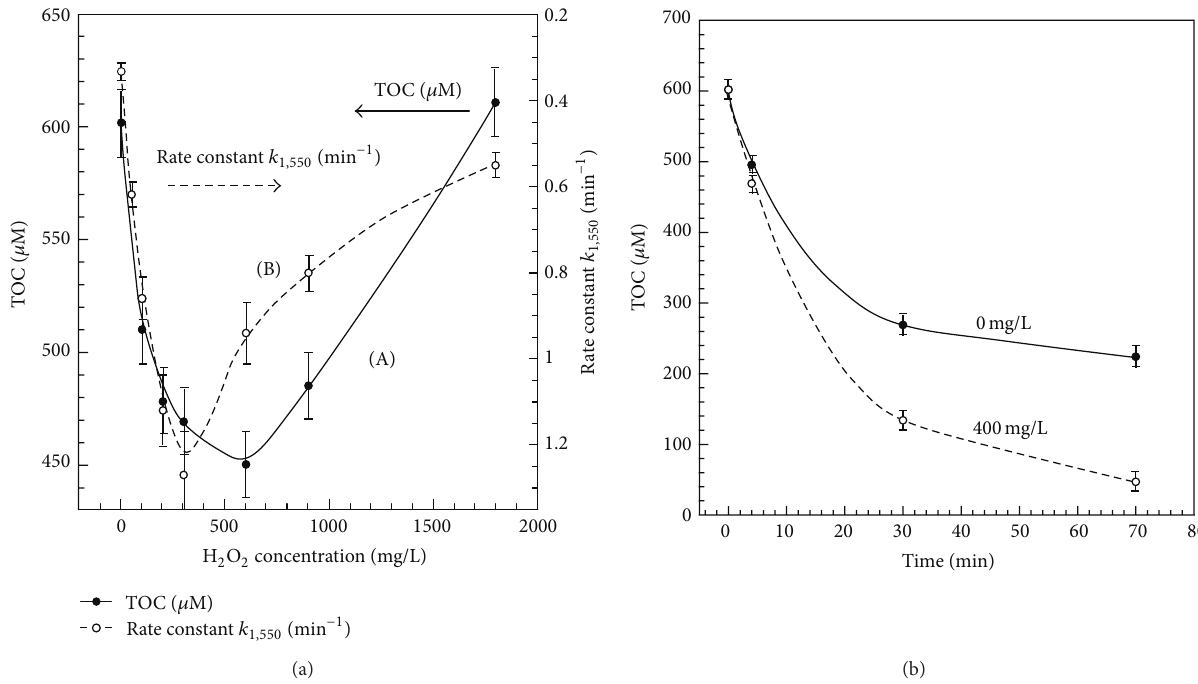
Figure 5: (a) Total organic carbon concentration (filled circles, curve (A), left scale) and apparent rate constant 𝑘 1,554 (open circles, curve (B), right scale) of RhB solution (10.2mg/L) after 4 min of MW + UV irradiation ( 𝑃 = 30 ± 0.5 W and 𝑇 = 40 ± 1 ∘ C) versus [H 2 O 2 ] 0 . (b) Total organic carbon concentration of RhB aqueous solution (10.2mg/L) as a function of irradiation time ( 𝑃 = 30 ± 0.5 W and 𝑇 = 40 ± 1 ∘ C) with [H 2 O 2 ] 0 = 400 mg/L (open circles) and without (filled circles).